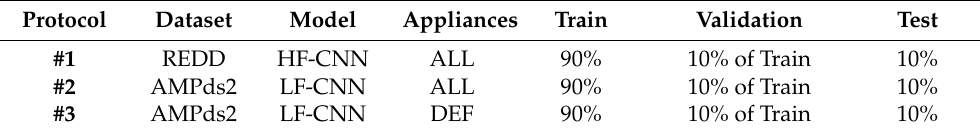
Table 3. Three experimental protocols including train/test splits and evaluated